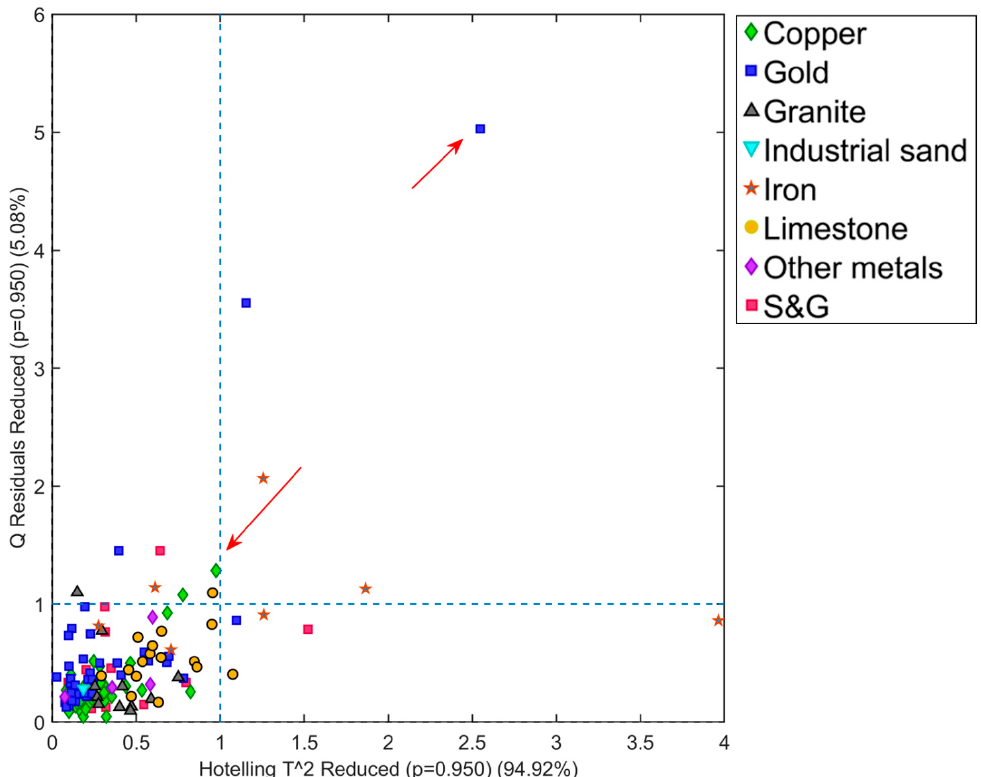
Figure A7. Hotelling T 2 v. Qresidual values from PCA model for FTIR spectra.